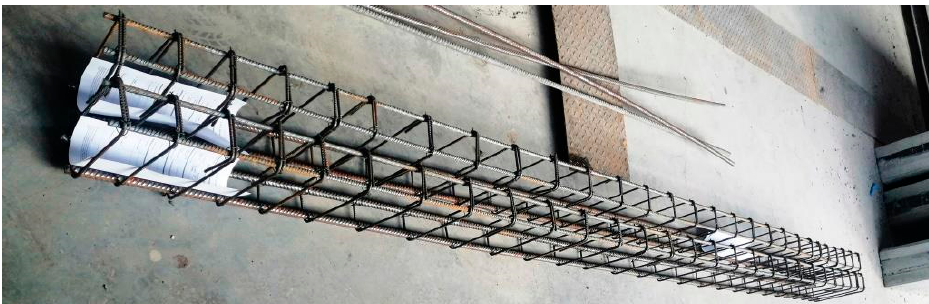
Figure 2. Dimensions and arrangement of rebars in the RC beams (dimensions in cm).